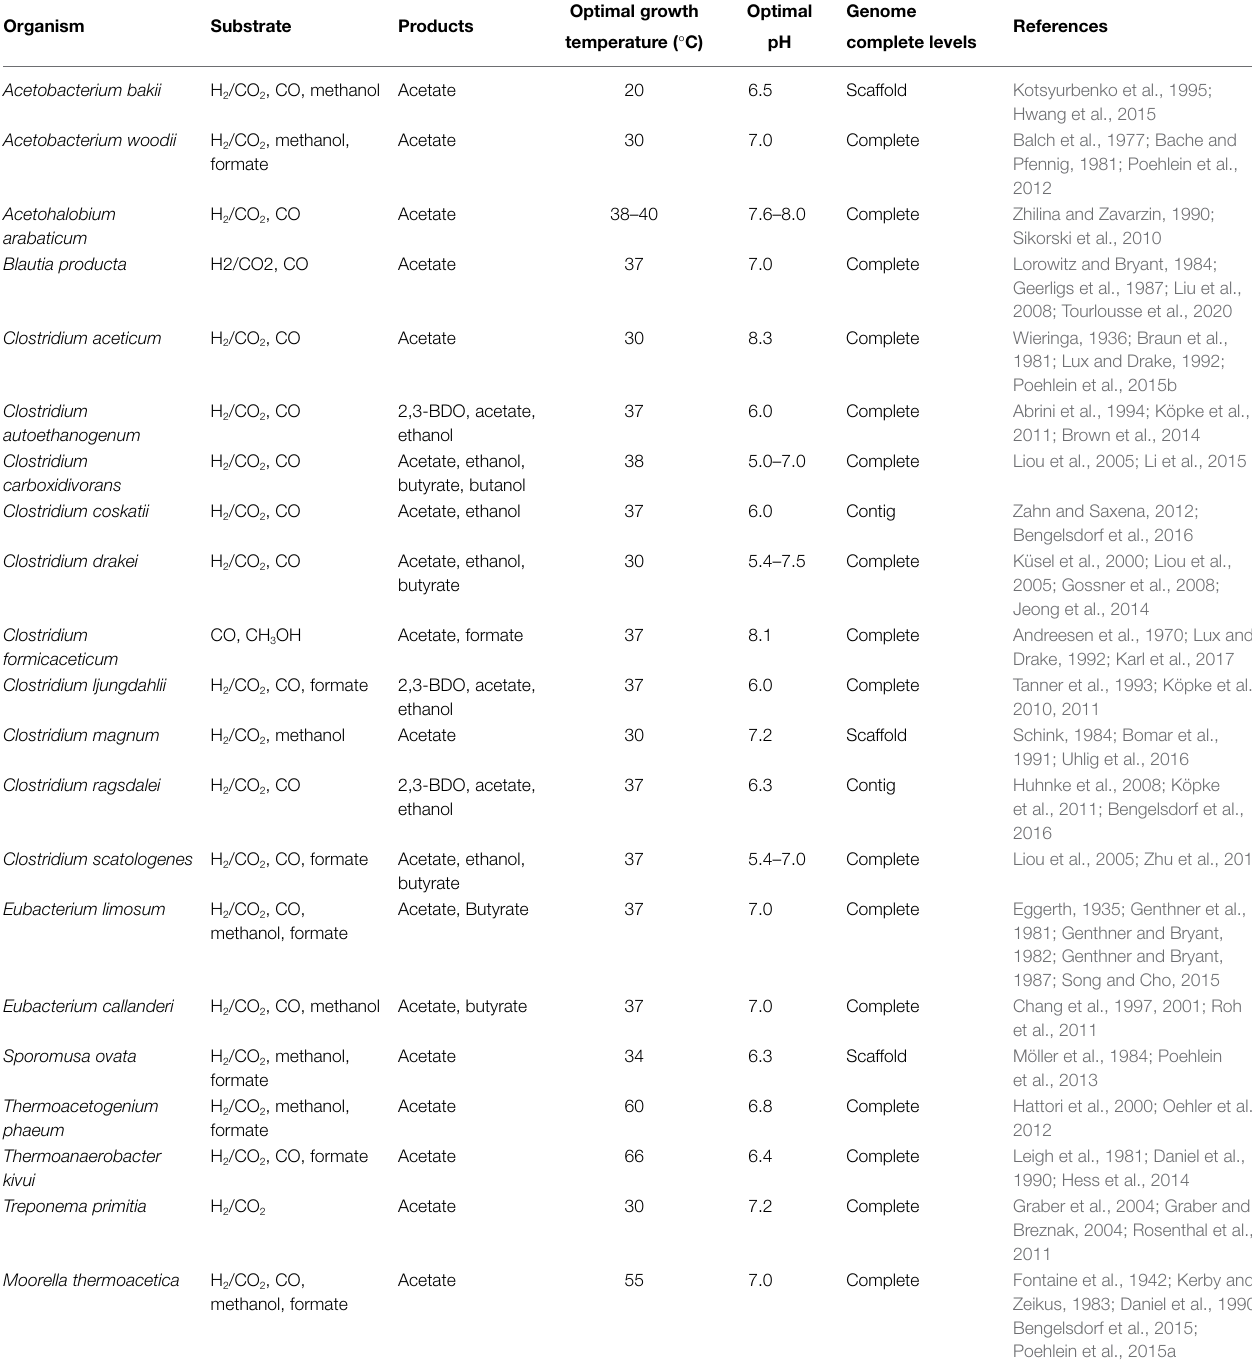
TABLE 1 | Features of diverse acetogenic